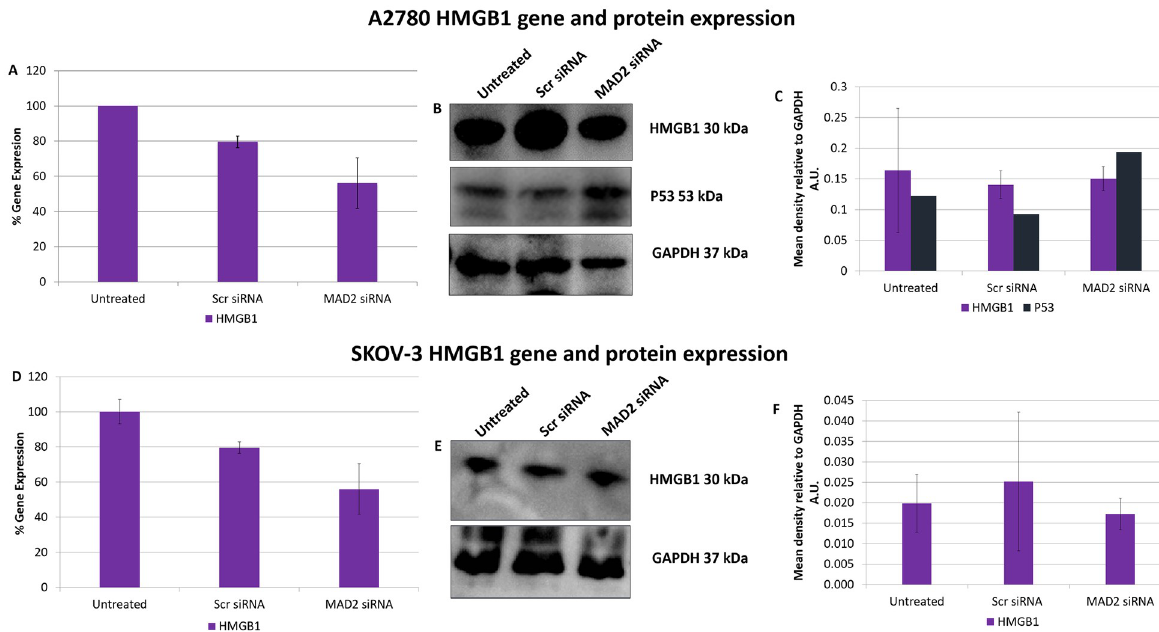
Fig 5. SiRNA knockdown of MAD2 does not alter HMGB1 gene or protein expression in A2780 or SKOV-3 cells. HMGB1 gene expression levels in A2780 (A) and SKOV-3 cells (D) following a 72 hour knockdown of MAD2. HMGB1 and P53 protein expression was also examined in A2780 cells using western blot analysis (B) and densitometry (C) while HMGB1 protein expression only was examined in P53 null SKOV-3 cells using western blot analysis (E) and densitometry (F). No significant change in HMGB1 gene or protein expression was observed in SKOV-3 cells nor was any change observed in HMGB1 gene expression or HMGB1 or P53 protein expression in A2780 cells post knockdown of MAD2 for 72 hours. Results are expressed as mean +/-SD. Note :- Blots are cropped from original images available in the S1 Raw Images.